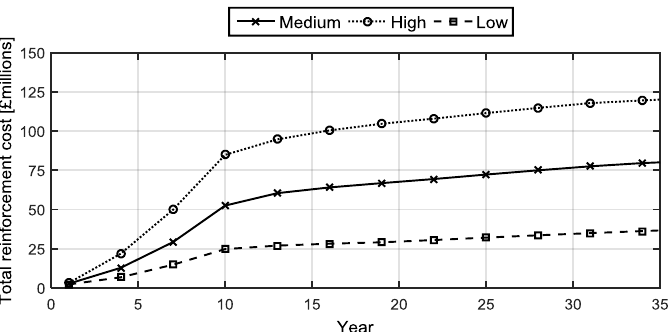
Figure 5 . Cost to re-conductor problematic feeders at a cost of £80/m and an entire feeder is reconductored if there is overvoltage. Cash flows are discounted.